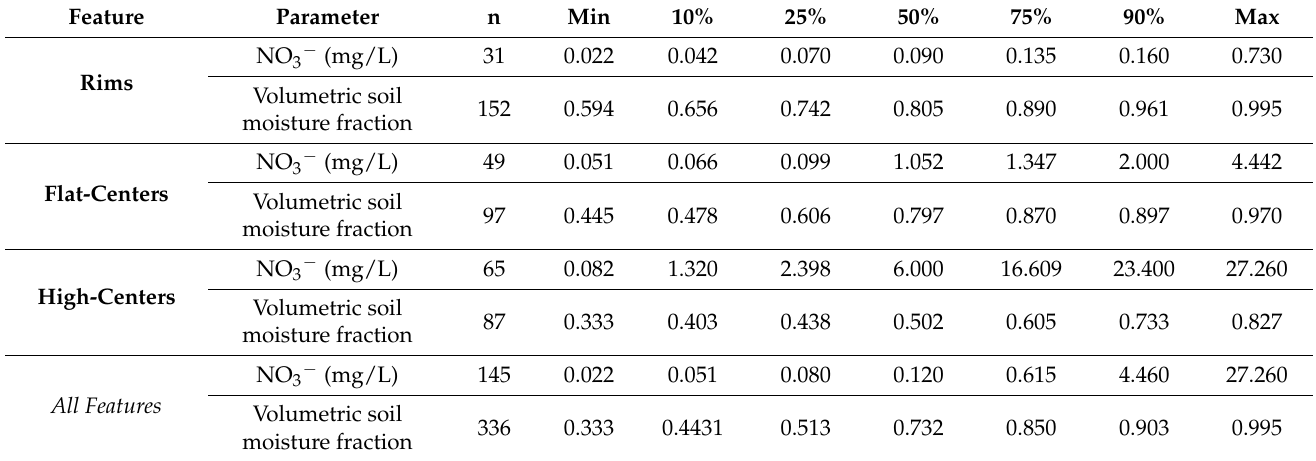
Table A1. Statistical distribution breakdown of all NO 3 − concentrations and volumetric soil moisture content data (synthesized from the 2012, 2013, 2016, and 2017 field campaigns) by elevated polygonal microtopographic feature (rims, flat-centers, high-centers, and all features), including minimum value, the 10th, 25th, 50th, 75th, and 90th percentiles of data distribution, and maximum value. Q1 is equal to the 25th quantile of data distribution, Q2 is equal to the 50th quantile of data distribution, and Q3 is equal to the 75th quantile of data